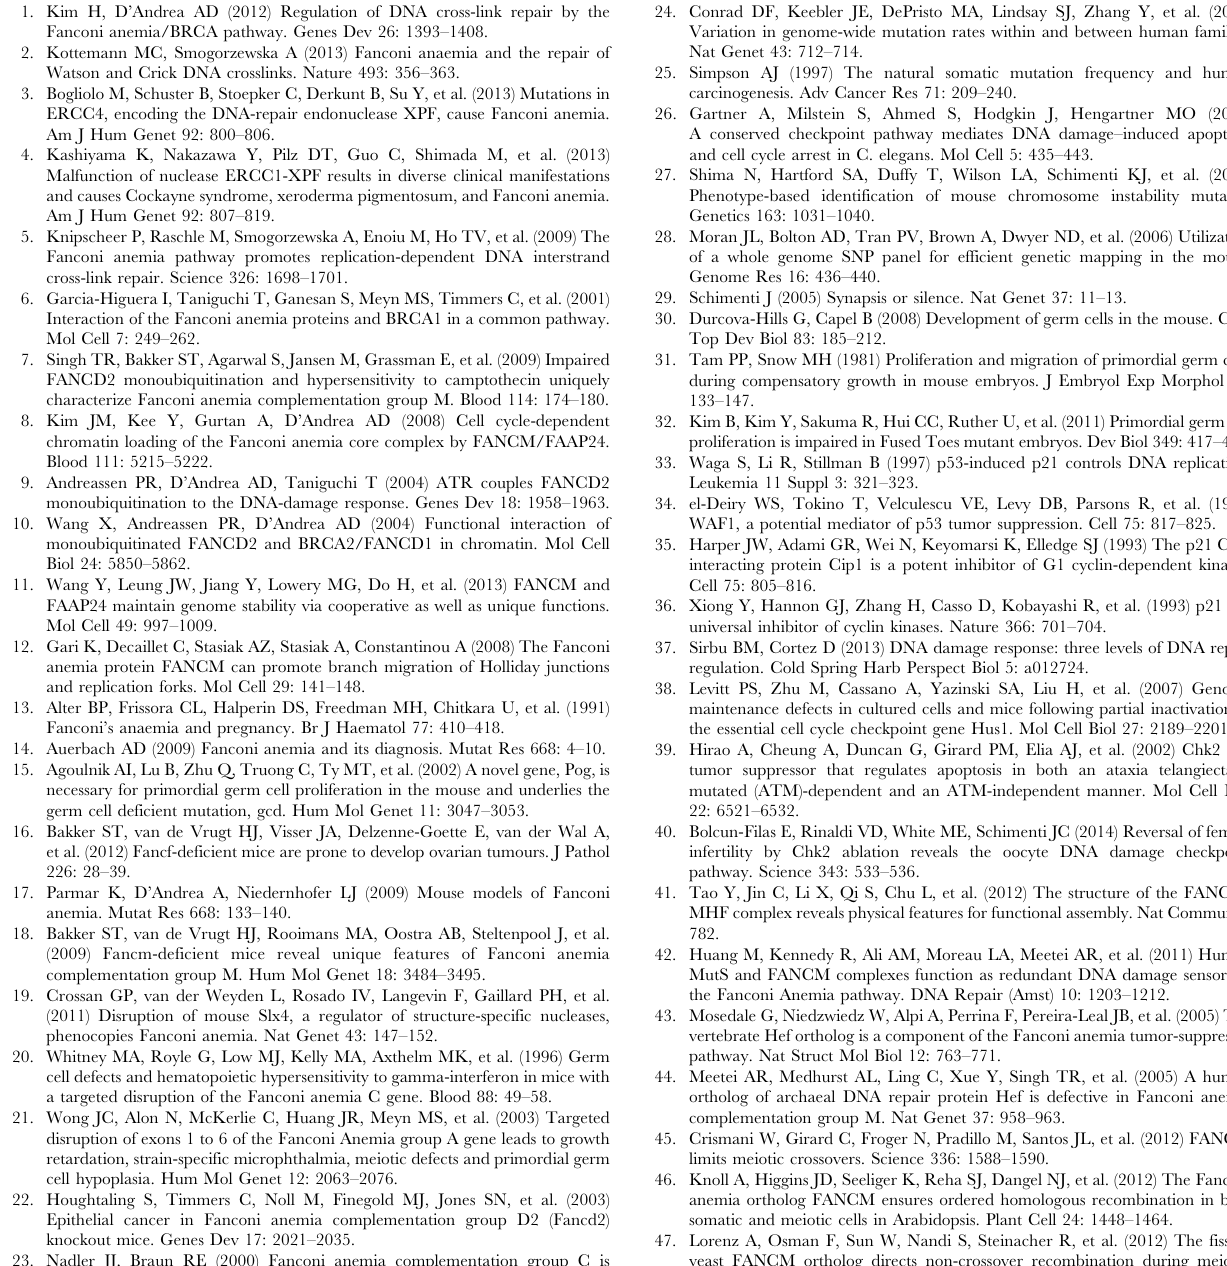
Table S1 Viability of Fancm mutant mice. Table S2 Tumor Frequency of Fancm mutants. Table S3 Histopathology of Fancm mutant